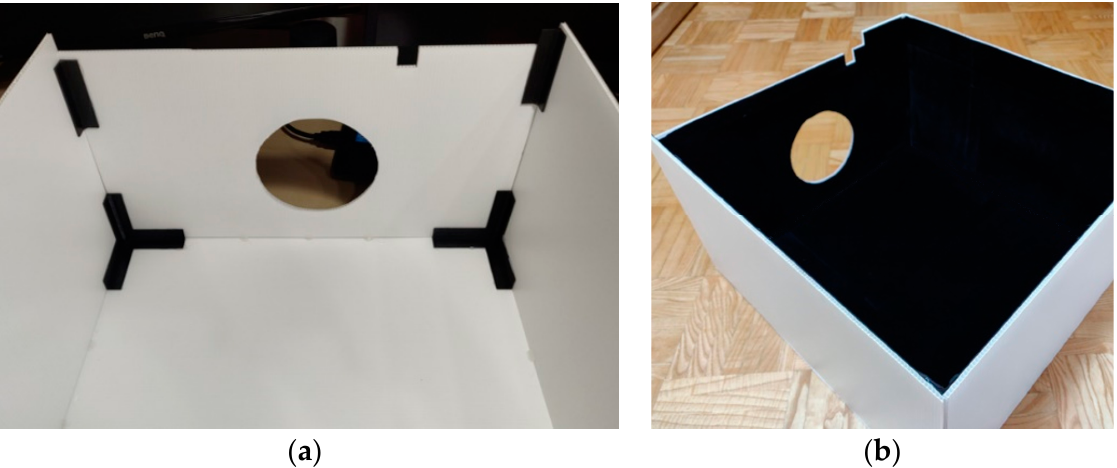
Figure 8. ( a ) Assembling the chamber; ( b ) Inner walls of the chamber covered with black velour flocking material.